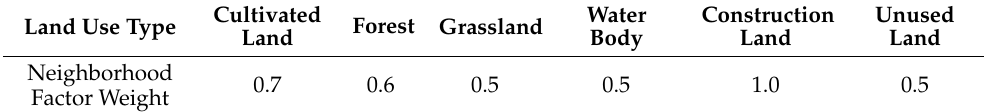
Table 2. Neighborhood factor weight ( W k